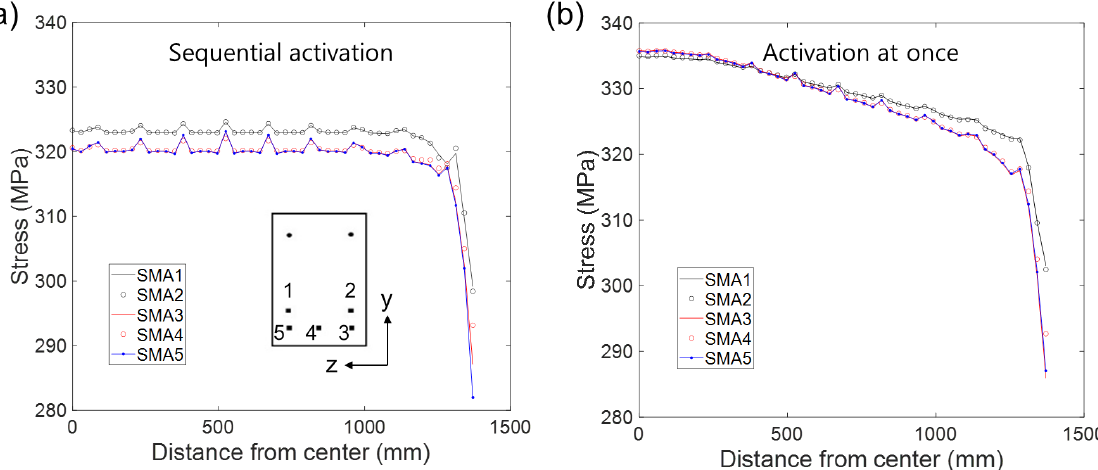
Figure 8. Normal x -axis stress distributions along Fe-SMA bars after activation, calculated by FE simulations. ( a ) With sequential activation of 5 Fe-SMA bars and ( b ) with 5 Fe-SMA bars activated at once.